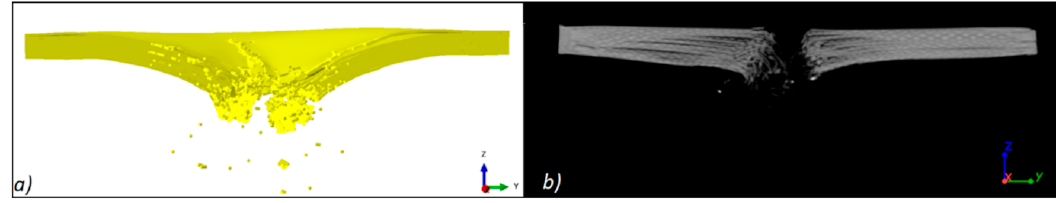
Figure 18. Cross-section of the panel after the projectile has passed: ( a ) simulation result, ( b ) experiment result.